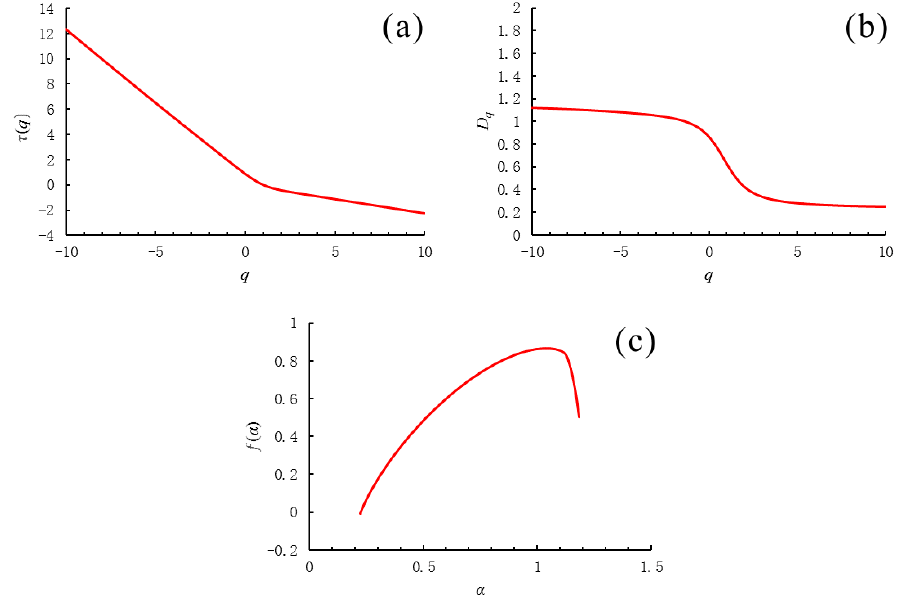
Figure 7. Multifractal analysis of the MICP data in the tight sandstone. ( a ) the mass exponent τ ( q ) ; ( b ) the generalized dimension spectrum q ∼ D q ; ( c ) the multifractal spectrum α ∼ f ( α ) . As q increases from − 10 to 10, (cid:1830) (cid:3044) gradually decreased, eventually approaching a balance, where D − 10 represents D min and D 10 represents D max . D 0 , D 1 and D 2 also are important dimension spectrum